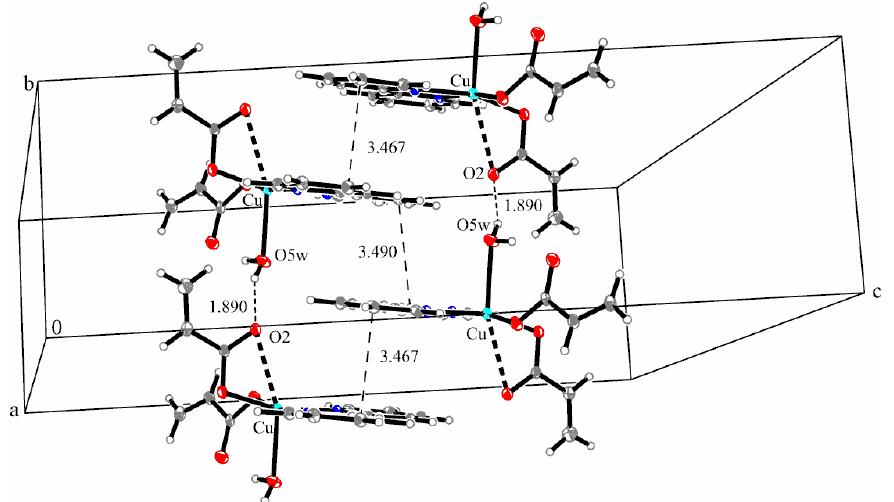
Figure 6. Packing diagram presenting the O–H … O hydrogen bond and π … π interactions along the b - axis in complex ( 3 ).